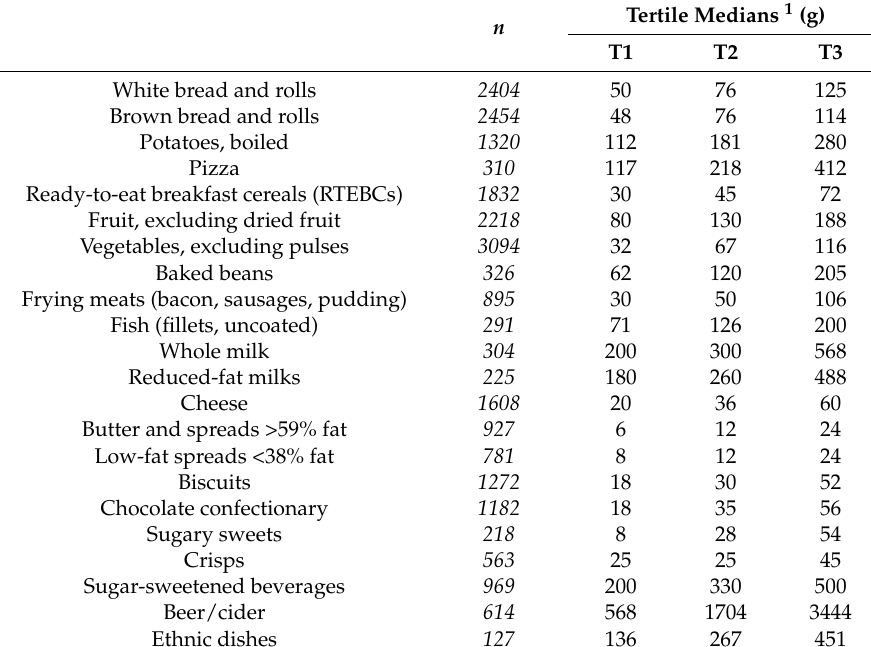
Table 2. Number of eating occasions ( n ) and median portion weights (g) consumed by portion size tertiles for foods included in the current